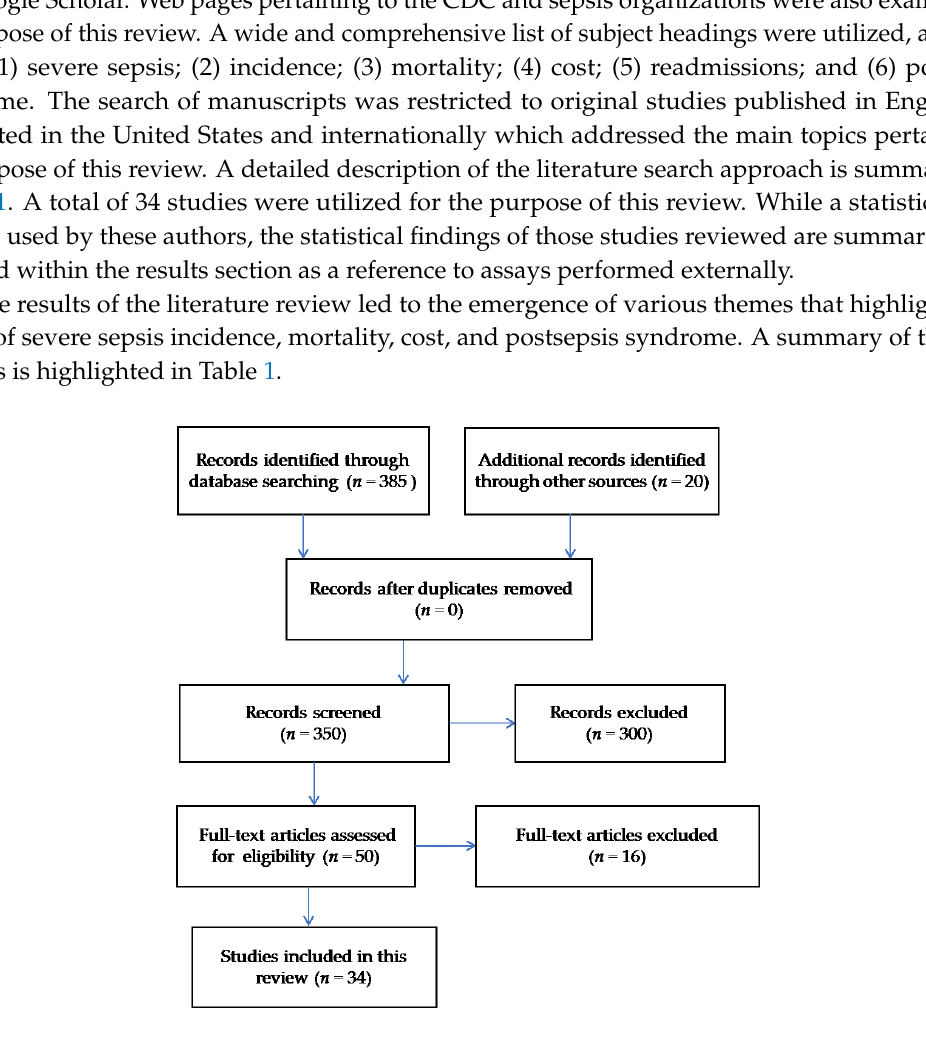
Figure 1. Literature search using the Preferred Reporting Items for systematic Reviews and Meta Analyses (PRISMA) flow diagram approach.